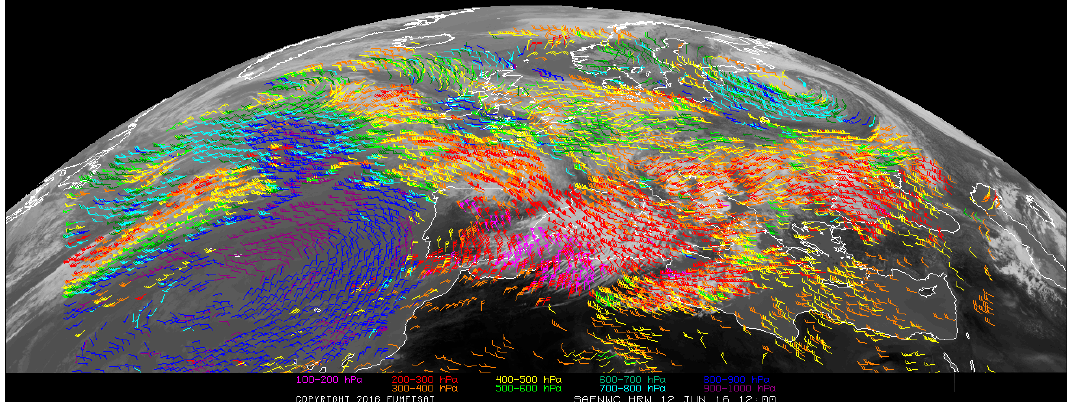
Figure 1. NWC/GEO-HRW output example of atmospheric motion vectors (AMVs) in the European and North Atlantic region, considering the default conditions for processing (12 June 2016, 12:00 UTC, MSG-3 satellite). Color coding based on the AMV pressure.